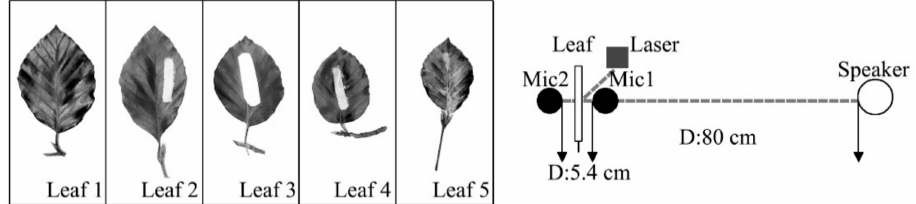
Figure 5. Experimental Setup and the photos of leaves and paper